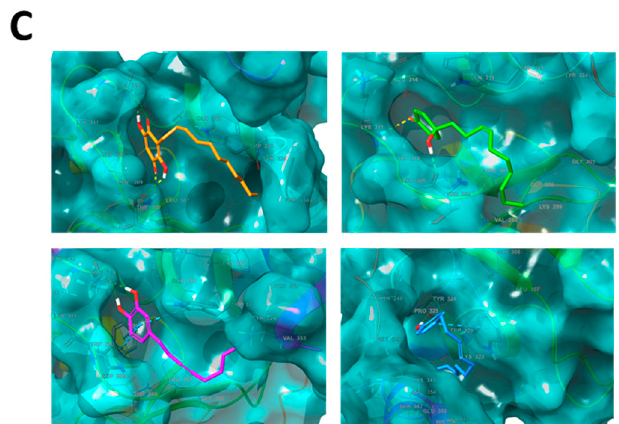
Figure 11. X-linked inhibitor of apoptosis protein (XIAP) as a molecular target of Piper genus-derived compounds. ( A ) Molecular docking and ( C ) dynamics analysis of embelin (orange), erioquinol (green), eriopodol A (purple) and gibbilimbol B (blue) in complex with the baculovirus IAP repeat (BIR)-3 domain of XIAP (PDB code 5C83). Interacting residues are displayed in wireframe, hydrogen bonds are displayed in yellow dot lines and π - π stacking interactions are displayed in blue dot lines. ( B ) Protein-ligand root mean square deviation (RMSD) trajectory of the atomic positions for ligands (red, Lig fit Prot) and the receptor (blu, C α positions) BIR-3 domain of XIAP, for the dynamics trajectory of 50 ns.